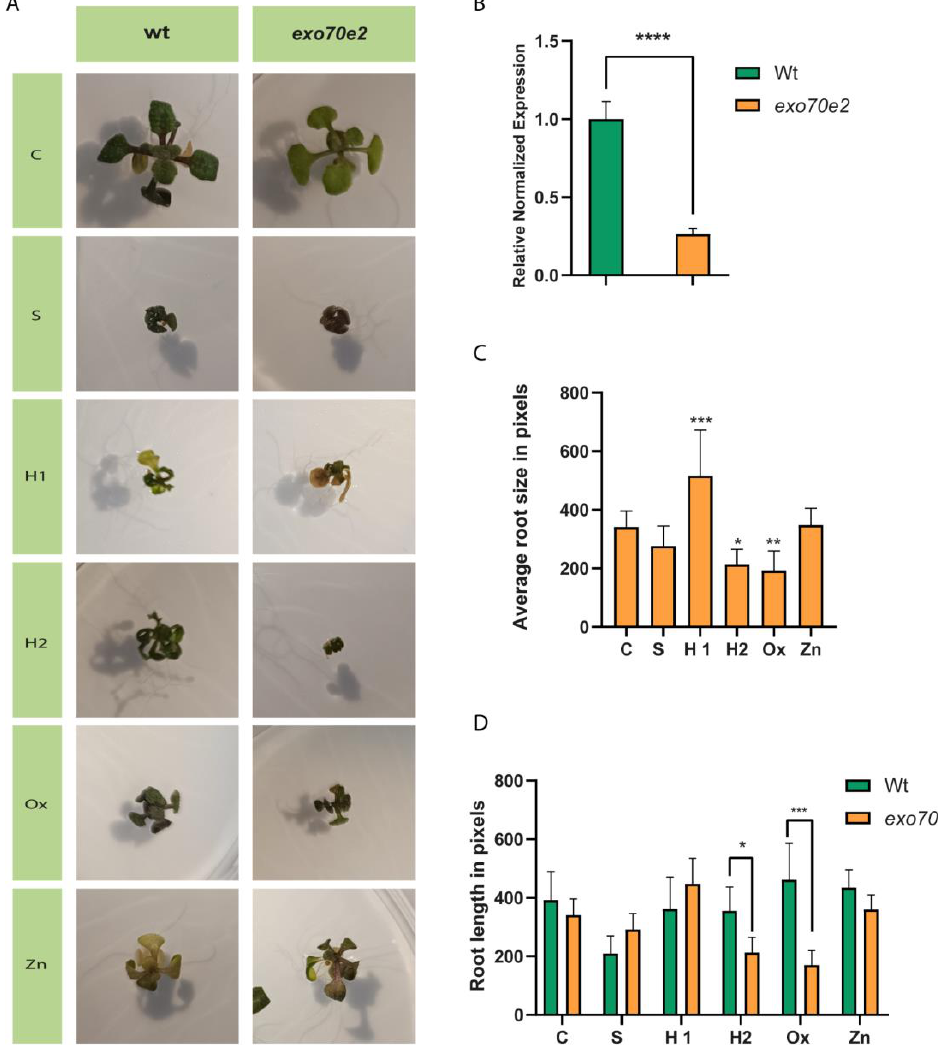
Figure 1. Biometric analysis of exo70e2 T-DNA Arabidopsis line and comparison with wild type (wt). ( A ) Comparison of Arabidopsis thaliana seedlings from wt and exo70e2 germinated under stress conditions. ( B ) Bar plot showing the relative normalised expression, by qPCR analysis, of AtEXO70e2 in wt plants and in the exo70e2 background. ( C ) Bar plot showing the average root size of exo70e2 under stress conditions, compared to control. ( D ) Bar plot of the average root size of exo70e2 plants, germinated under stress, compared to wt plants in the same conditions. All data presented were acquired 12 – 14 days post-germination, with three or more biological replicates (n ≥ 3). As shown in ( B ), the exo70e2 line is a knockdown for this gene; however, it significantly impaired the development of the seedling, particularly when exposed to high-dose drought stress and oxidative conditions. Statistically experimental values are represented by: * ( p value ≤ 0.05), ** ( p value ≤ 0.01); *** ( p value ≤ 0.001); **** ( p value < 0.0001). C — control; S — salt stress (50 mM NaCl); H1 — drought stress (50 mM mannitol); H2 — drought stress (10 mM mannitol); Ox — oxidative stress (0.5 mM hydrogen peroxide); Zn — metal poisoning stress (150 µM zinc sulphate).